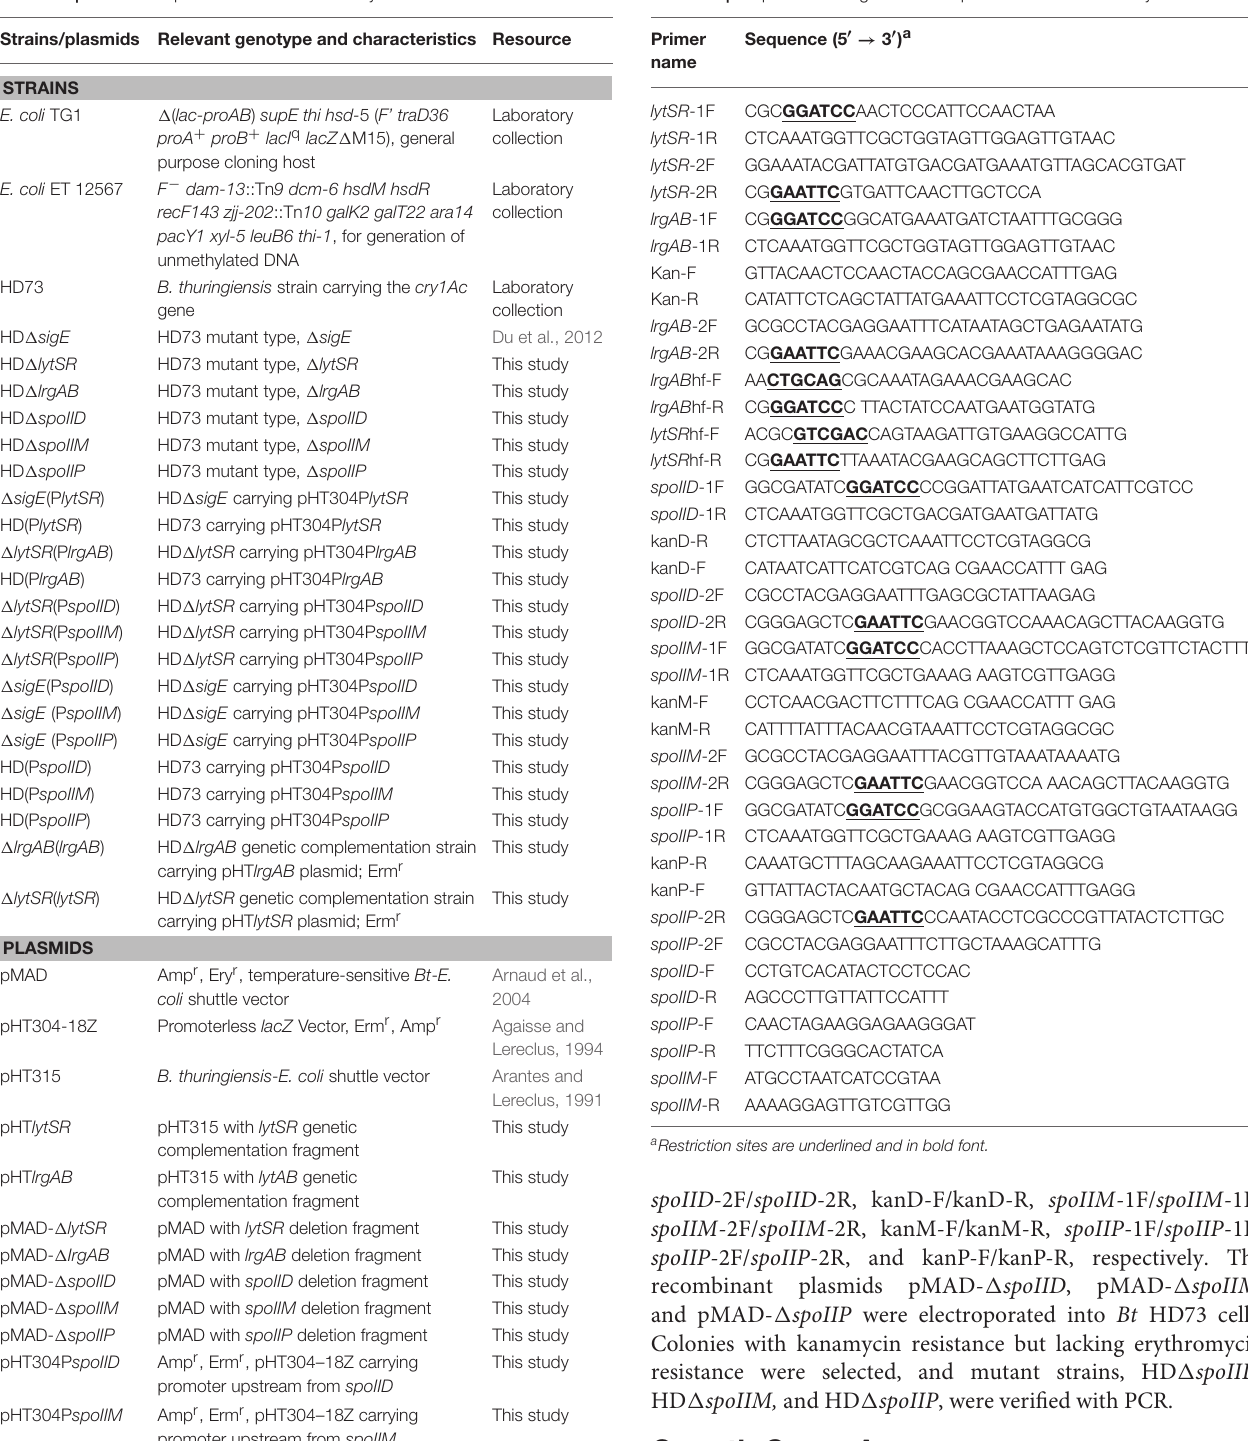
TABLE 1 | Strains and plasmids used in this study. TABLE 2 | Sequences of oligonucleotide primers used in this